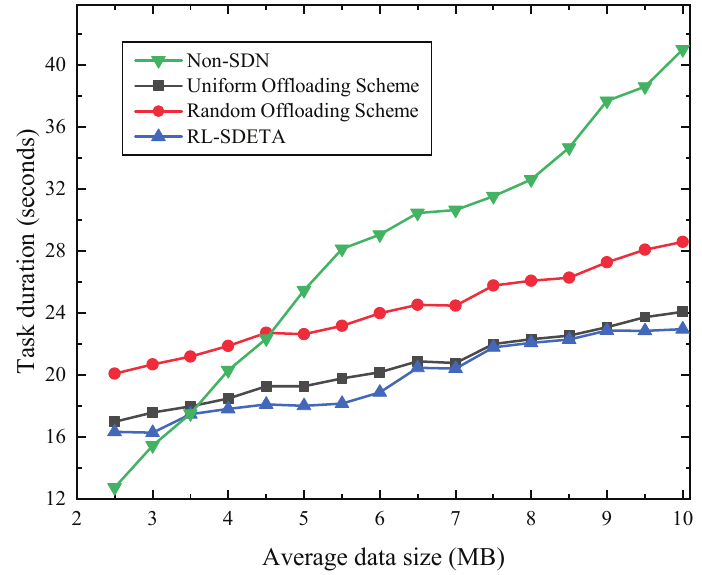
Figure 5. Impact of data size amount on task